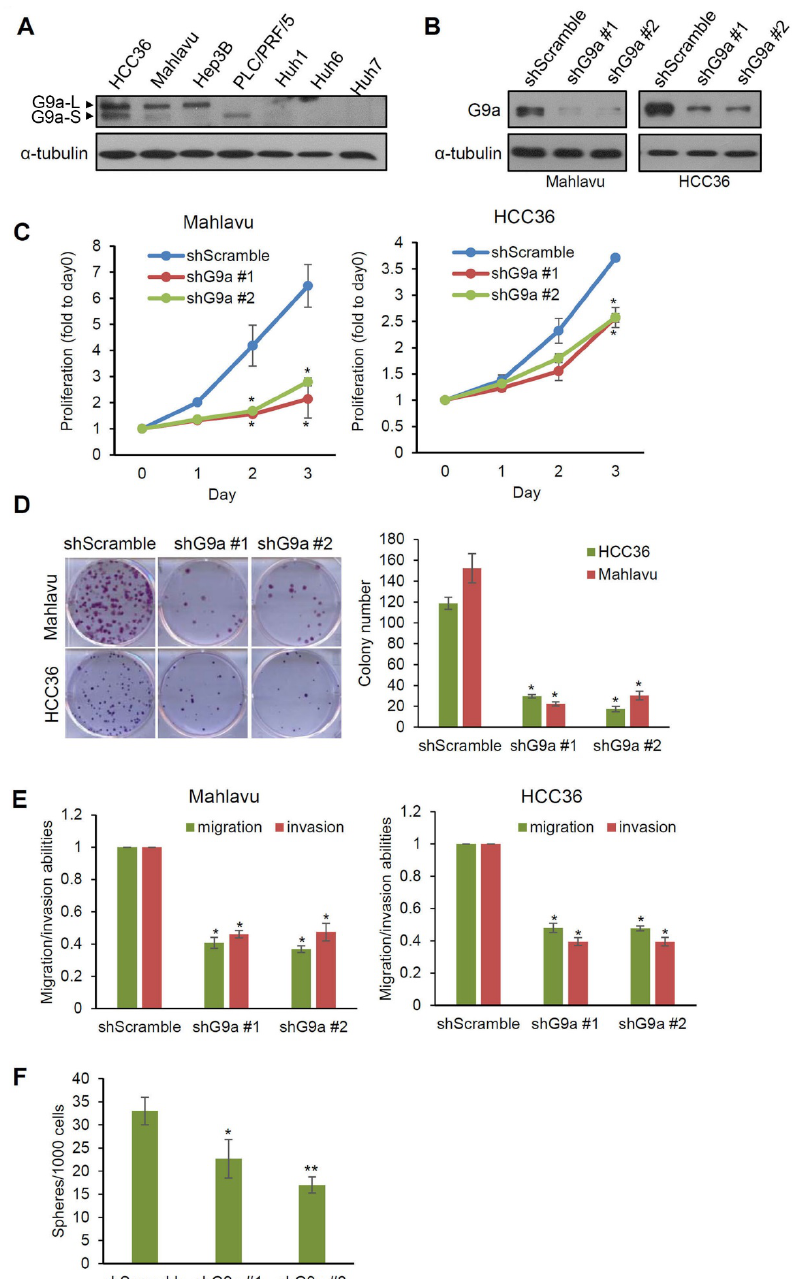
Figure 2. G9a is associated with aggressive phenotypes of hepatocellular carcinoma (HCC) cells. ( A ) G9a protein expression levels of seven HCC cell lines were determined by immunoblotting. The short form (G9a-S, 160 KDa) or long form (G9a-L, 180 KDa) of G9a can be detected in these cells and are indicated by arrows. ( B ) Knockdown efficiencies of two G9a-specific shRNAs were examined by immunoblotting in Mahlavu and HCC36 HCC cells. ( C ) Three-day proliferation curves were determined in Mahlavu and HCC36 cells with either G9a shRNAs or control shRNA expressions by an MTT assay. Proliferation rates were significantly lower in cells stably transfected with G9a shRNA compared to control cells. ( D ) The clonogenic cell survival assay and the quantification results of Mahlavu and HCC36 cells with control or G9a shRNA expressions. All values are the means of three independent experiments. ( E ) Transwell migration and invasion assays of G9a knockdown in Mahlavu and HCC36 cells. Quantitative plot showing multiples of the control. ( F ) Sphere-forming ability of Mahlavu cells with control or G9a shRNA expression after 2 weeks of inoculation. Three independent replicates were performed in each experiment. α -Tubulin was used as a loading control in the immunoblot experiments. * p < 0.05, ** p < 0.01. Error bars indicate the standard deviation. All uncropped immunoblotting images for this study are summarized in Figure